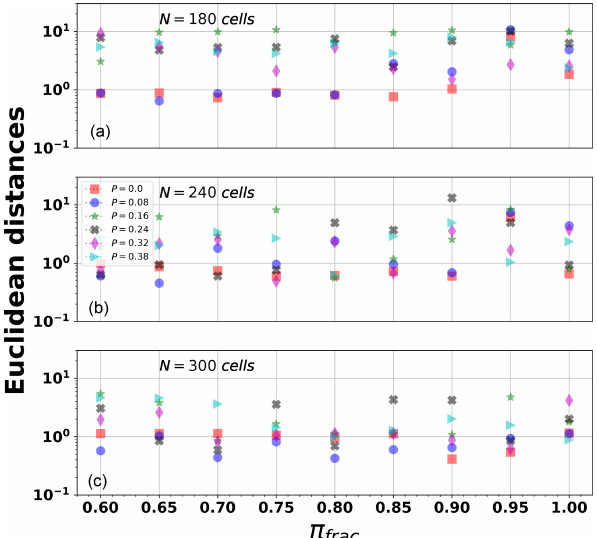
Figure 15. Euclidean parametric distance r E − M puted for the synthetic series ( M min = 2 . 0) considering three input parameters ( N , P , π frac ). From panel (a) to (c) , N = 180, N = 240, and N = 300 (cells per lateral size in the domain).